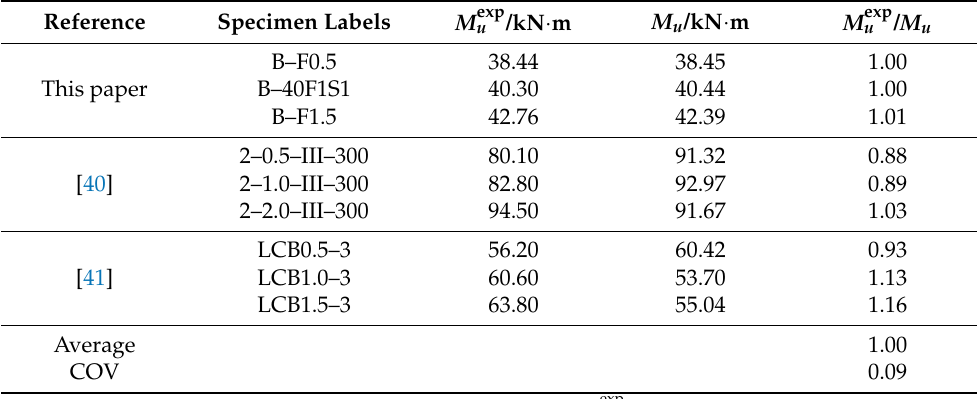
Table 2. Comparisons of tests and predicted flexural bearing